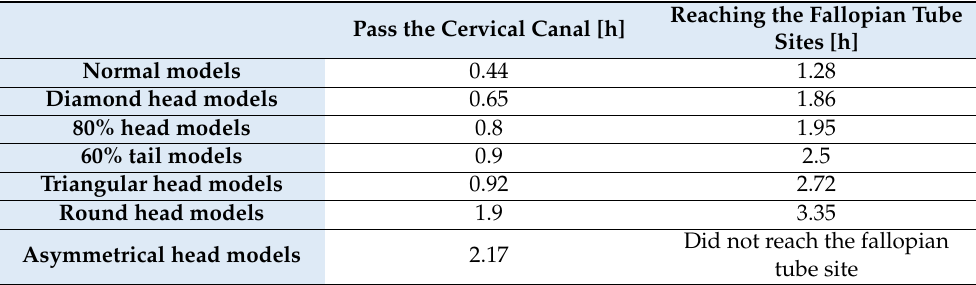
Table 2. Time positions (average) of the normal and abnormal models through the human female cervical canal and uterine cavity.